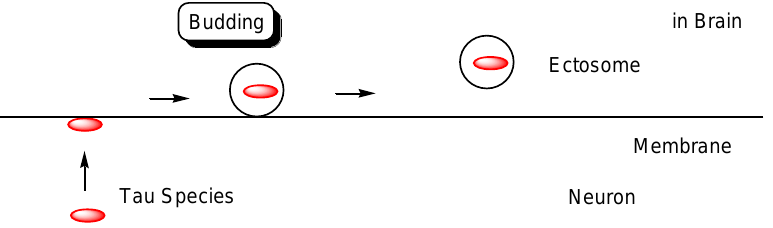
Microdomain Figure 10. Tau secreted from neurons through an unconventional non-vesicular mechanism. in Brain Membrane MembraneNeuron NeuronTau Species Tunneling Nanotube Figure 11. Tau cell-to-cell transportation through tunneling nanotubes. 2.5. Tauopathies Tauopathy is a general term for neurodegenerative diseases with NFTs composed of tau proteins that originally spread via cell-to-cell transmission process and duplicated to tau seeds in recipient cells [25]. It is well known that disease-specific tau pathology is based on tau strains in AD, PiD, PSP, and CBD. Brain-derived tau oligomers from AD and dementia with Lewy bodies (DLB) were internalized through HSPG-mediated endocyto- sis using cortical neurons isolated from C57BL/6 mice, while those from PSP were inter- nalized through not only HSPG-mediated endocytosis but also through alternative mech- anisms [30]. Some tauopathies are associated with tau gene mutations. Thus, it is thought that arbitrary tau strains are doomed to induce the corresponding tauopathy-based struc- turalism by Lévi-Strauss. Tau oligomers composed of 3R and 4R isoforms were aggre- gated through the seeding of PSP brain-derived tau oligomers with 3R and 4R monomers